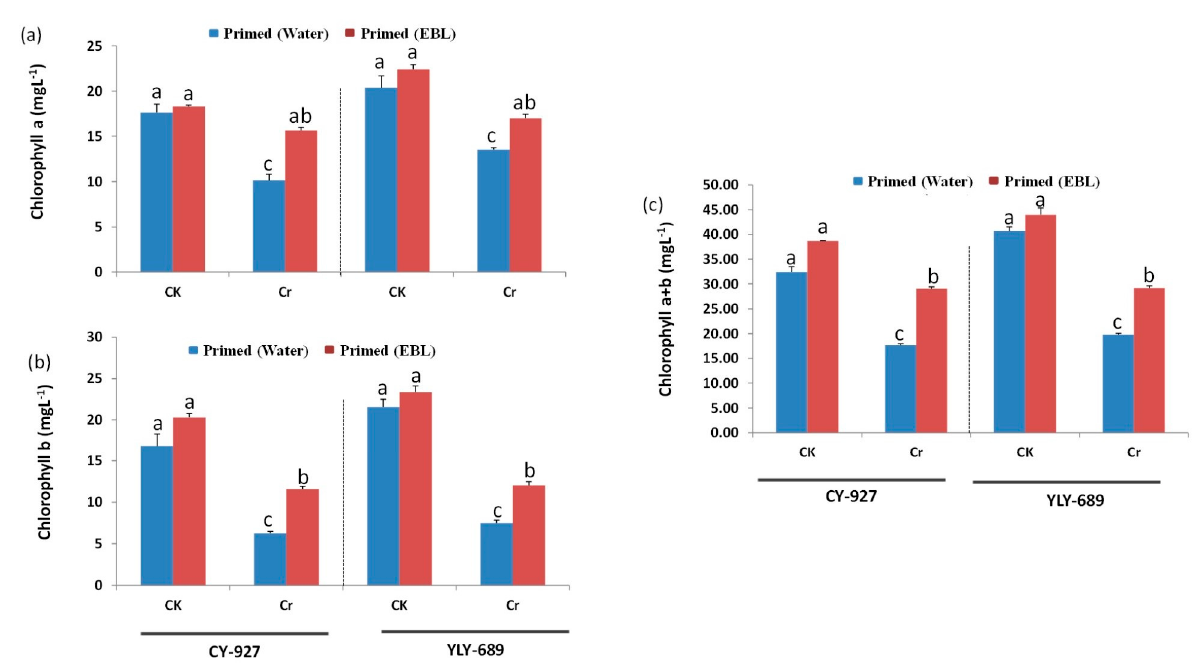
Figure 2. Effect of brassinosteroids on chlorophyll contents in two different rice cultivars under Cr toxicity. ( a ) Chlorophyll a contents in both rice cultivars; ( b ) Chlorophyll b contents in both rice cultivars; ( c ) Total Chlorophyll contents (Chlorophyll a+b) in both rice cultivars. The values presented are means ± SDs ( n = 3). Different letters (a–c) above bars show a significant difference at p < 0.05 among treatments.